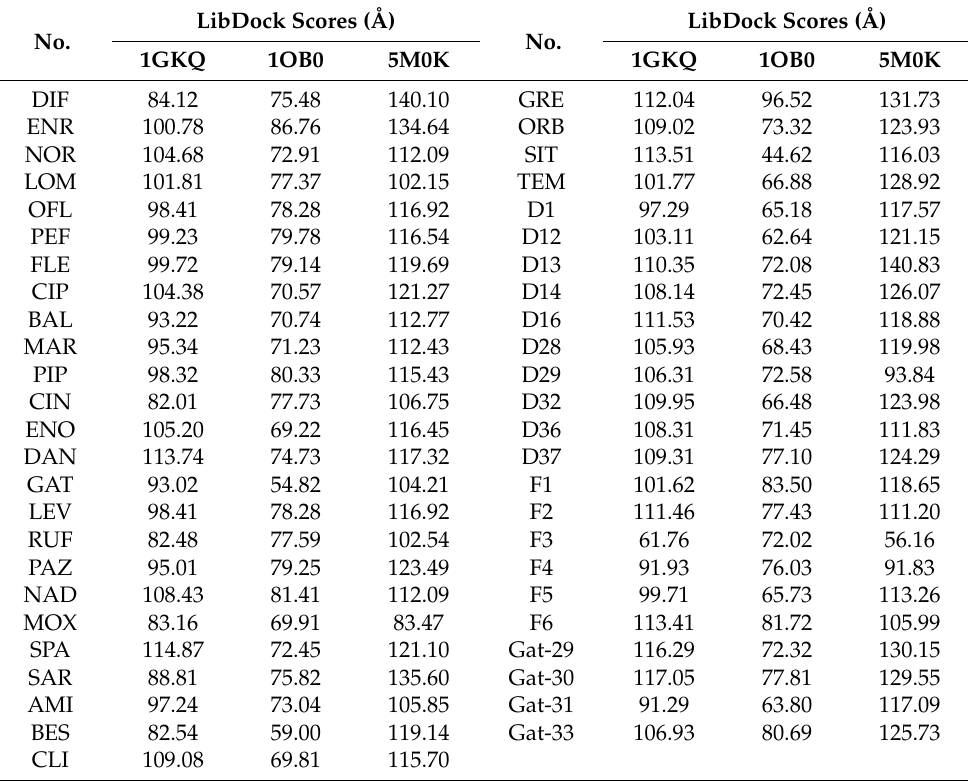
Table 2. Biodegradability levels of FQs at different target receptors (characterized by the Libdock Scores,